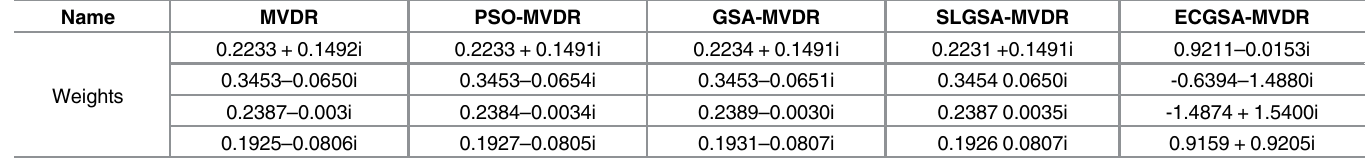
Table 10. Comparison of weight vectors for conventional MVDR, PSO-MVDR, GSA-MVDR, SLGSA-MVDR [28] and ECGSA-MVDR for user at 0° and interferences at 30°and 50°.